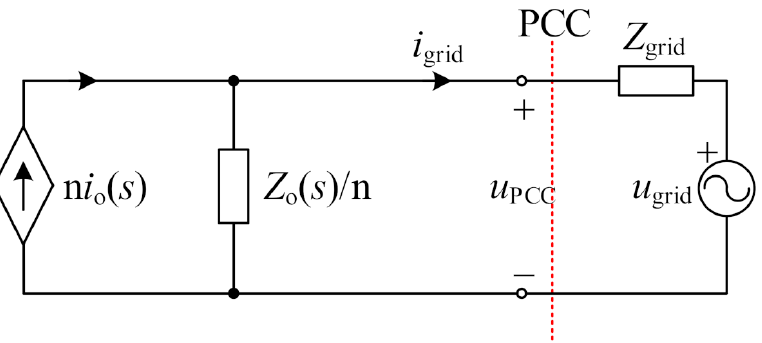
Figure 13. Simplified equivalent impedance network of converter cluster